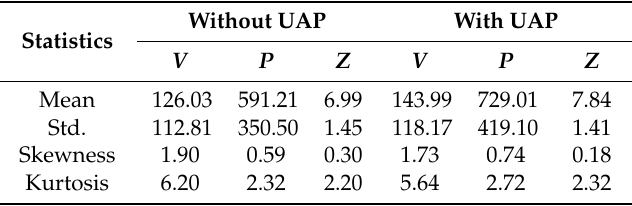
Table A2. Statistics of flood